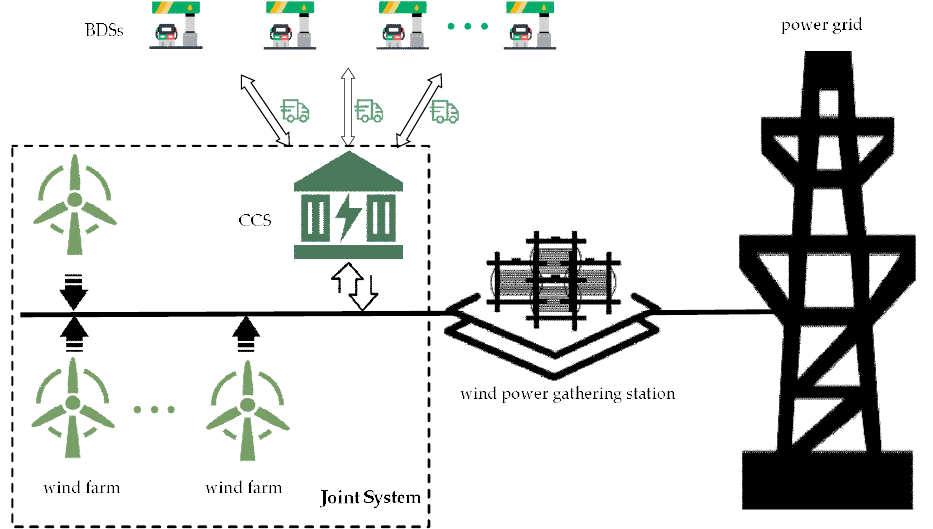
Figure 2. Structure diagram of the joint system.